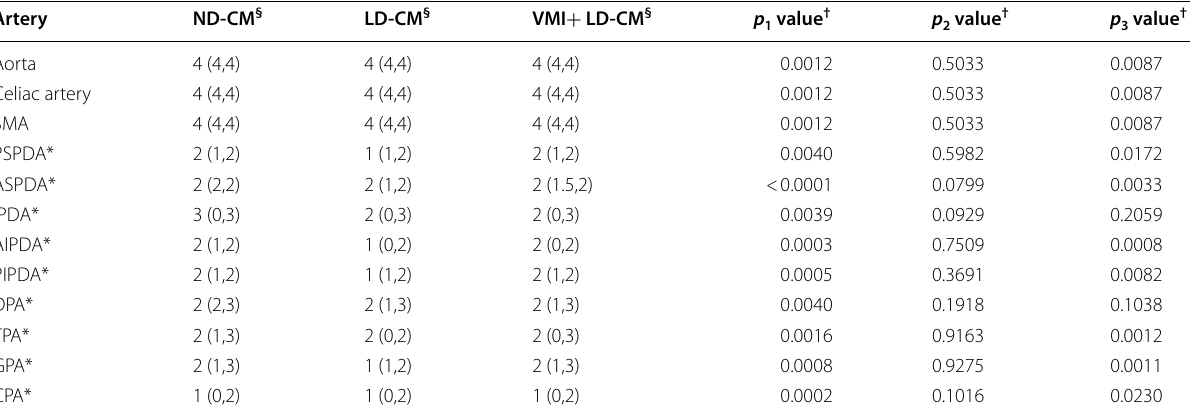
Data are means standard deviations or Median (P25, P75) ± * PSPDA posterior superior pancreaticoduodenal artery, ASPDA anterior superior pancreaticoduodenal artery, IPDA inferior pancreaticoduodenal artery, AIPDA anterior inferior pancreaticoduodenal artery, PIPDA posterior inferior pancreaticoduodenal artery, DPA dorsal pancreatic artery, TPA transverse pancreatic artery, GPA great pancreatic artery, CPA caudal pancreatic artery